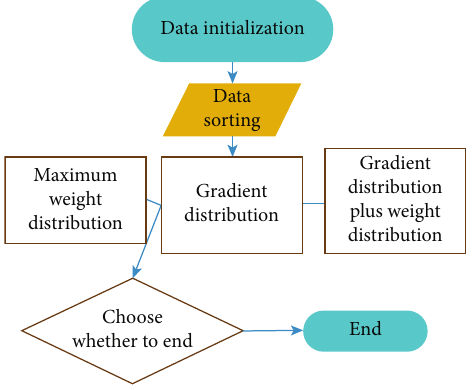
Figure 5: Speci fi c process of implementing Hungarian algorithm in